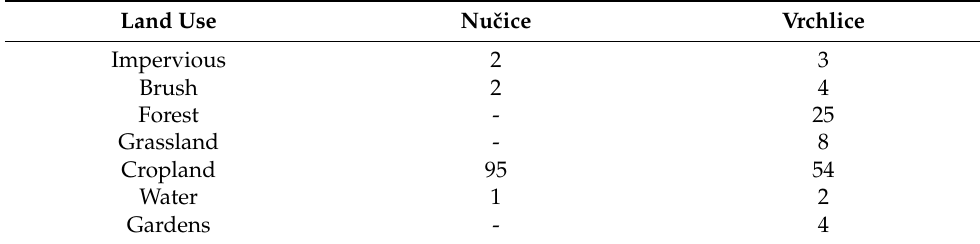
Table 1. Land use percent cover over the experimental basins. Land Use